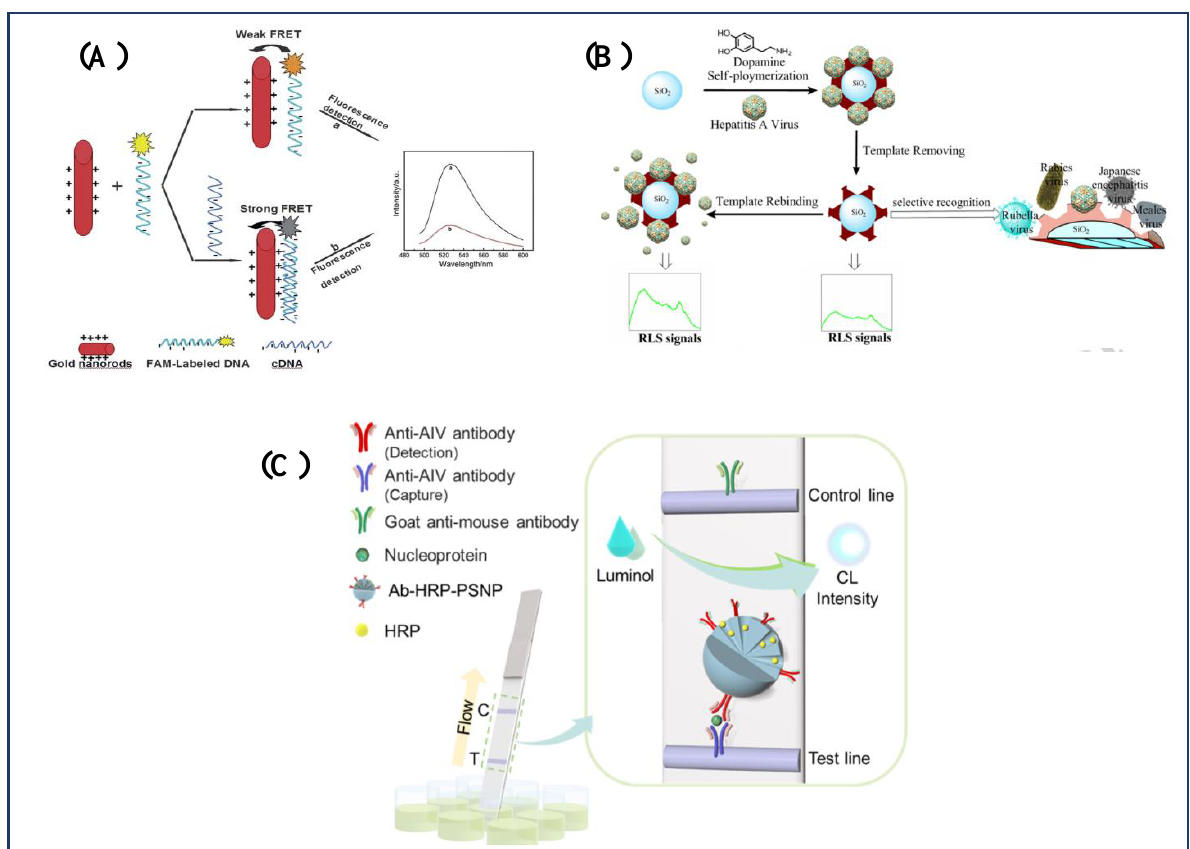
Figure 4. ( A ) Schematic representation of the strategy for DNA hybridization detection (adapted with permission from Lu et al., Analyst, 2013 [169] ); ( B ) Principle of preparation of the virus-MIPs and detection of virus (Hepatitis A) (adapted with permission from Yang et al., Biosensors, and Bioelectronics, 2017 [171] ); ( C ) Schematic illustration of porous silica nanoparticle-based chemiluminescent lateral flow immunoassay (CL-LFA) platform for the detection of avian influenza virus (AIV) nucleoproteins (adapted with permission from Jung et al., Analytical Chemistry, 2021 [178] ). Table 2. Fluorescence/chemiluminescence-based sensing platform for viral infection.